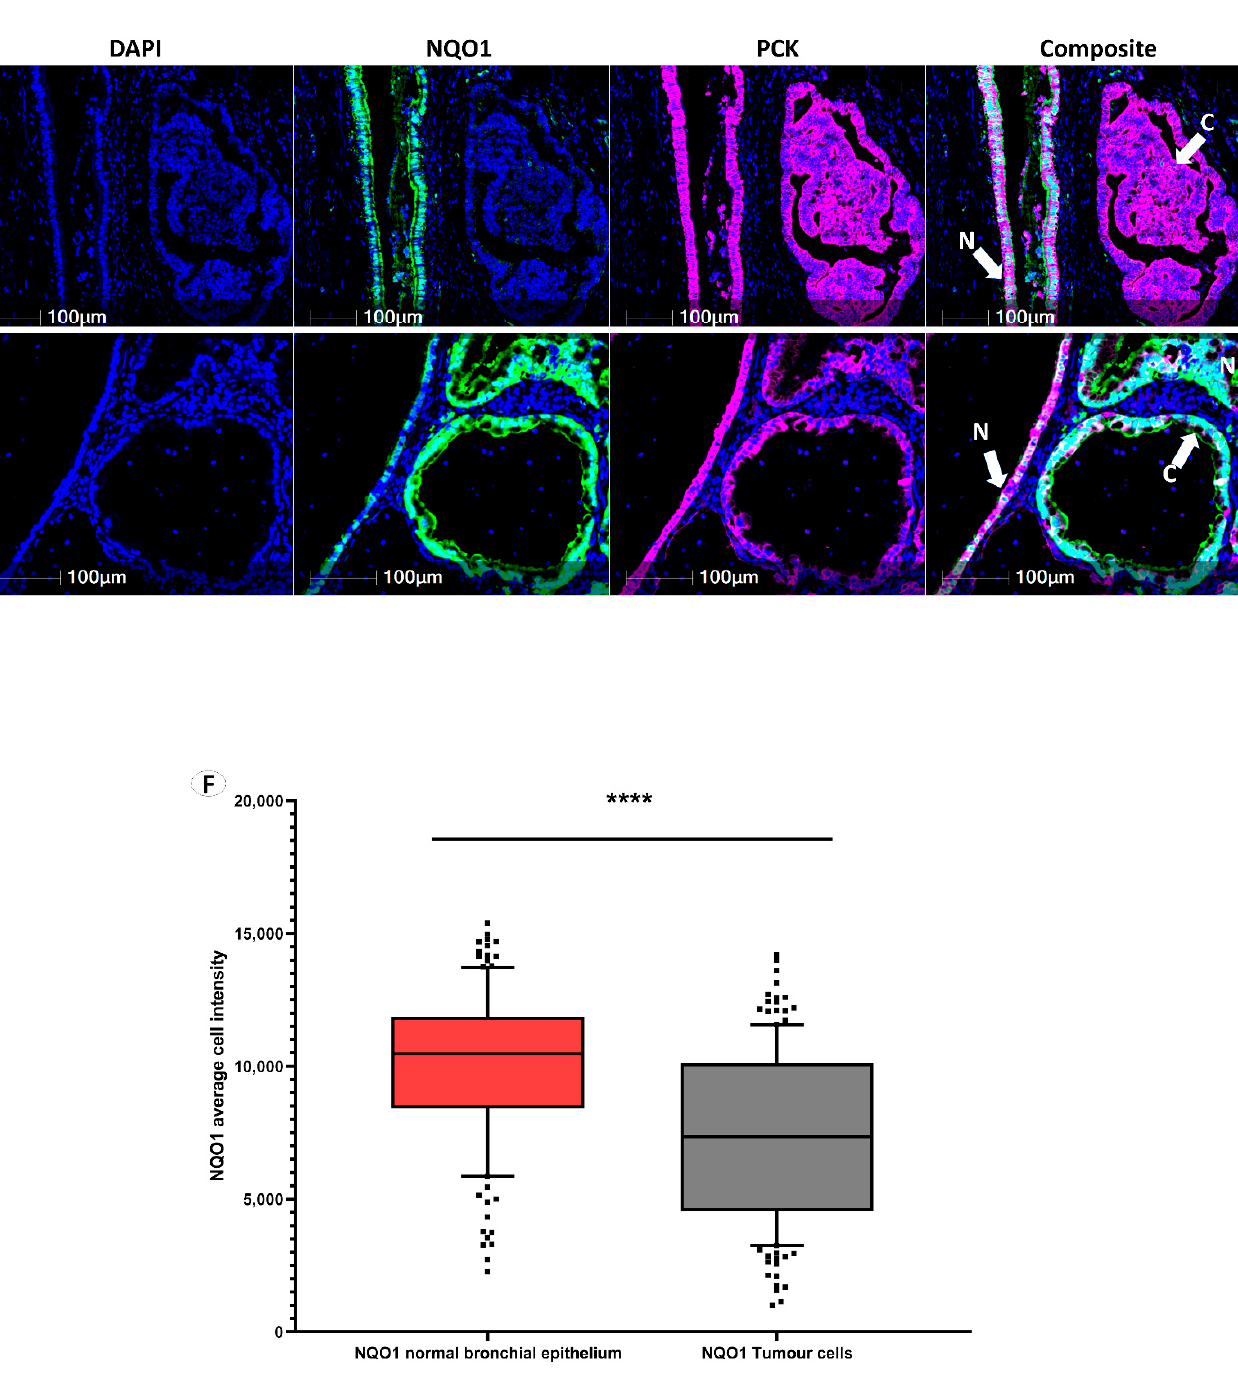
Figure 1. NQO1 protein abundance in normal lung tissue. ( A ) NQO1, NRF1 and NRF2 immuno- histochemical staining demonstrated normal bronchial epithelium, alveolar epithelium, mucosal gland, and lymphoid cells. ( B ) NQO1, NRF1 and NRF2 expression in nerve cells, endothelial cells, fibroblast cells and muscle (M) with the adjacent artery ( A ). ( C , D ) Multiplex immunofluorescence of lymphoid cell types adjacent to tumor tissue using DAPI (blue nuclear stain), cluster of differentiation markers (yellow), NRF1 (green), NQO1 (red) and NRF2 (purple). Composite images display DAPI, CD markers, NRF1, NQO1 and NRF2 overlay. ( E ) NQO1 (green stain) and pan-cytokeratin (pink cell structure stain highlighting bronchial epithelium and cancer cells). Composite images display DAPI, NQO1 and pan-cytokeratin overlay. N denotes normal bronchial epithelial cells, and C denotes cancer cells. ( F ) NQO1 intensity-based analysis displaying paired average NQO1 cell